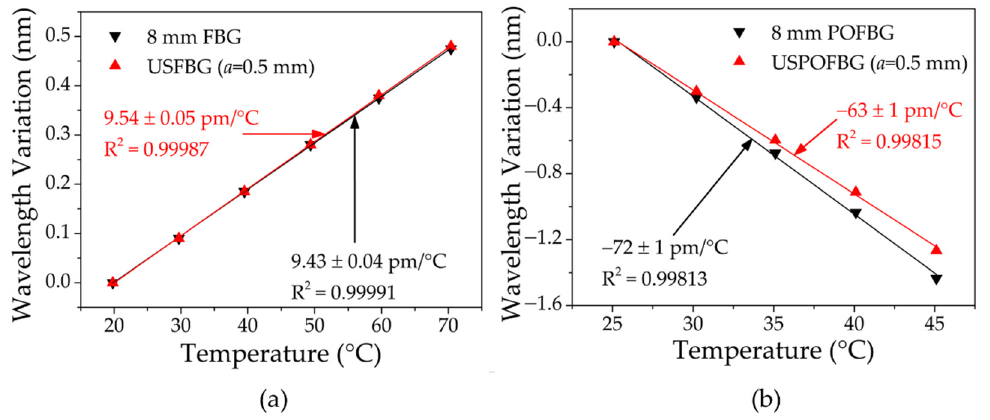
Figure 14. Wavelength variation of the 8 mm FBG and USFBG with increasing temperature: ( a ) in GF1 fiber; ( b ) in 3-rings undoped PMMA mPOF.